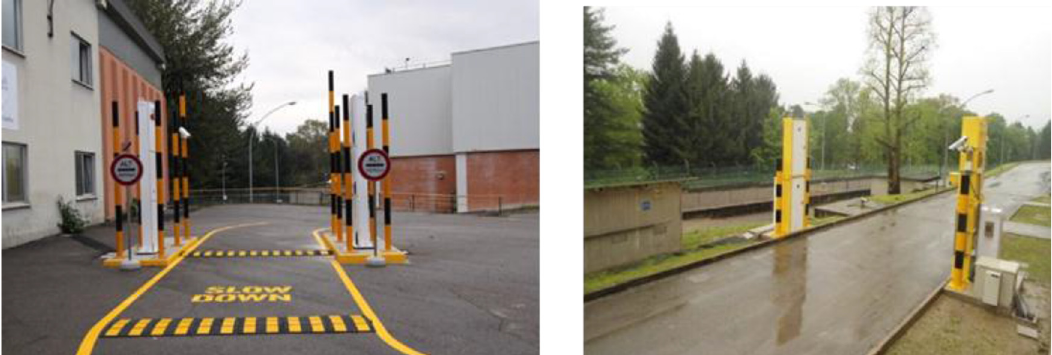
Fig. 7. European Nuclear Security Training Centre (EUSECTRA).